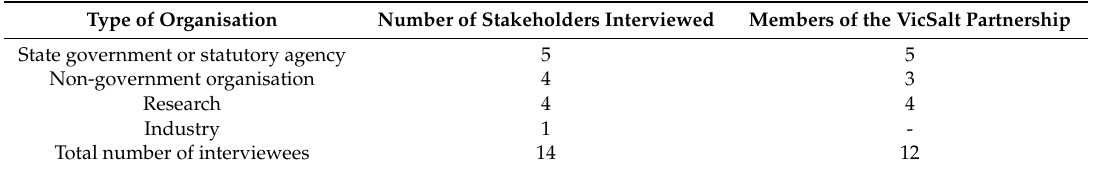
Table 1. Number of key stakeholders interviewed, by organisation